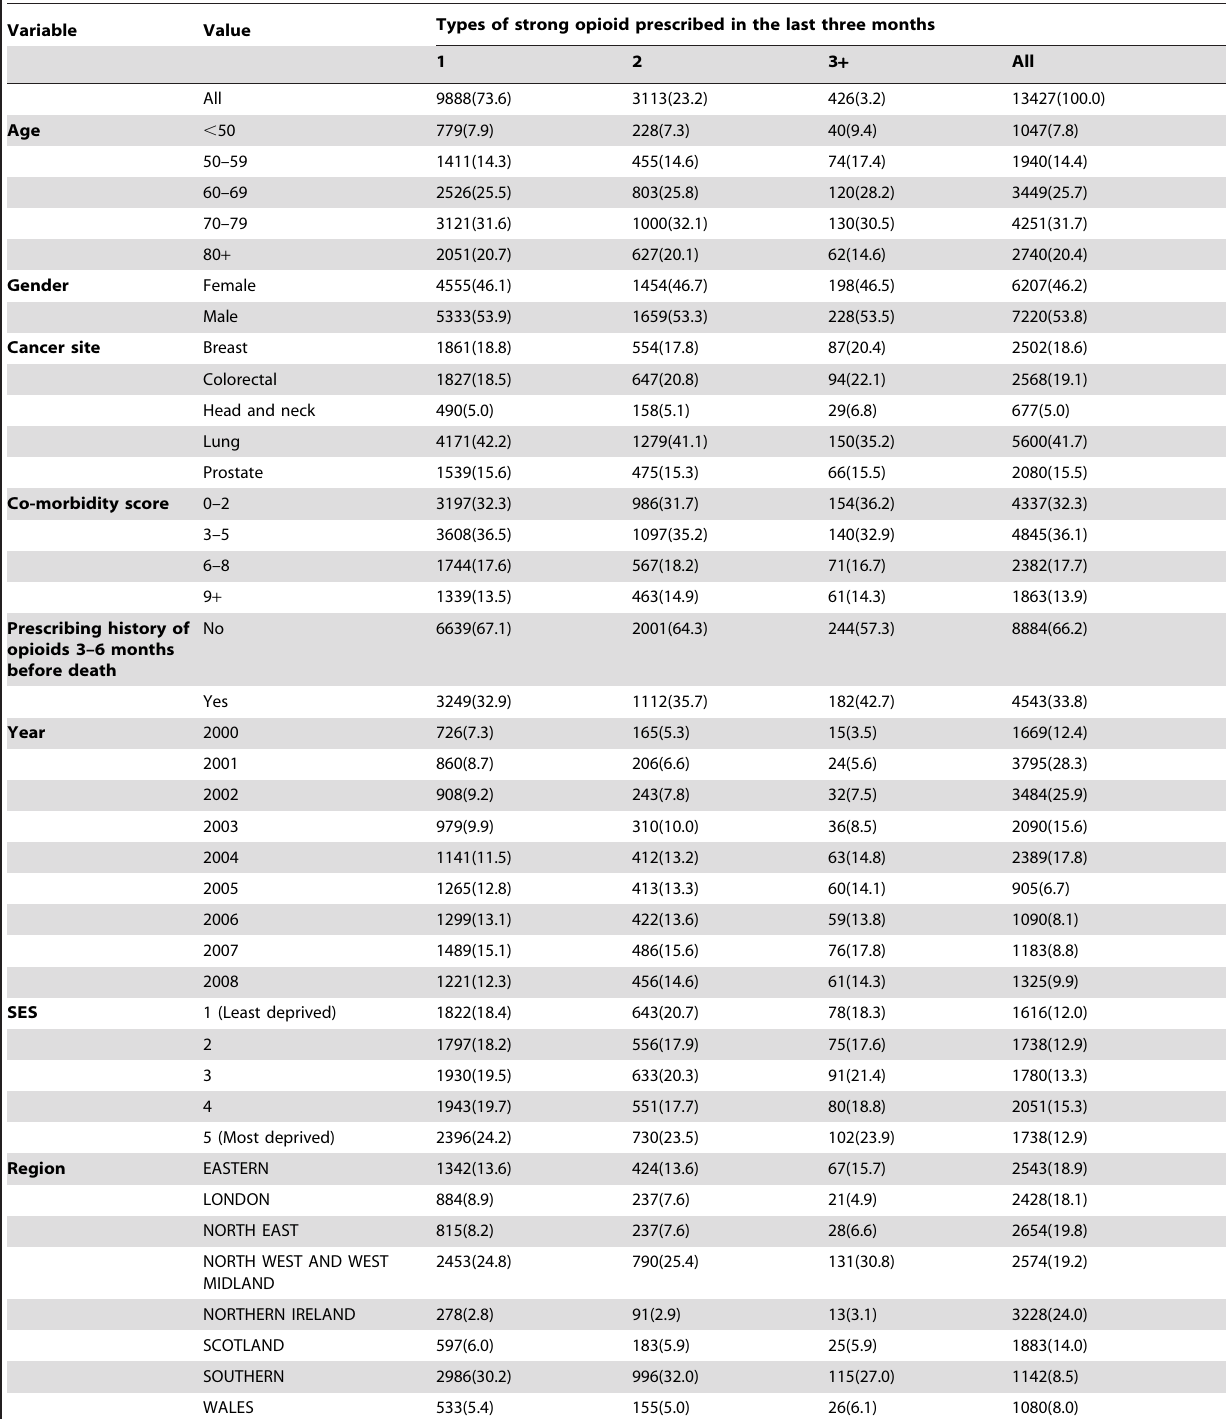
Table 1. Demographic and clinical characteristics of cancer patients receiving at least one prescription of strong opioids at the end of life, UK